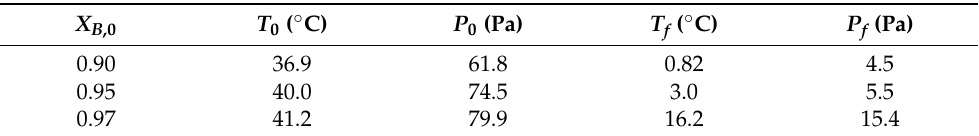
Table 3. The initial and final three-phase transformation conditions for the formation of p - chlorophenol solid product during the batch SC experiments.